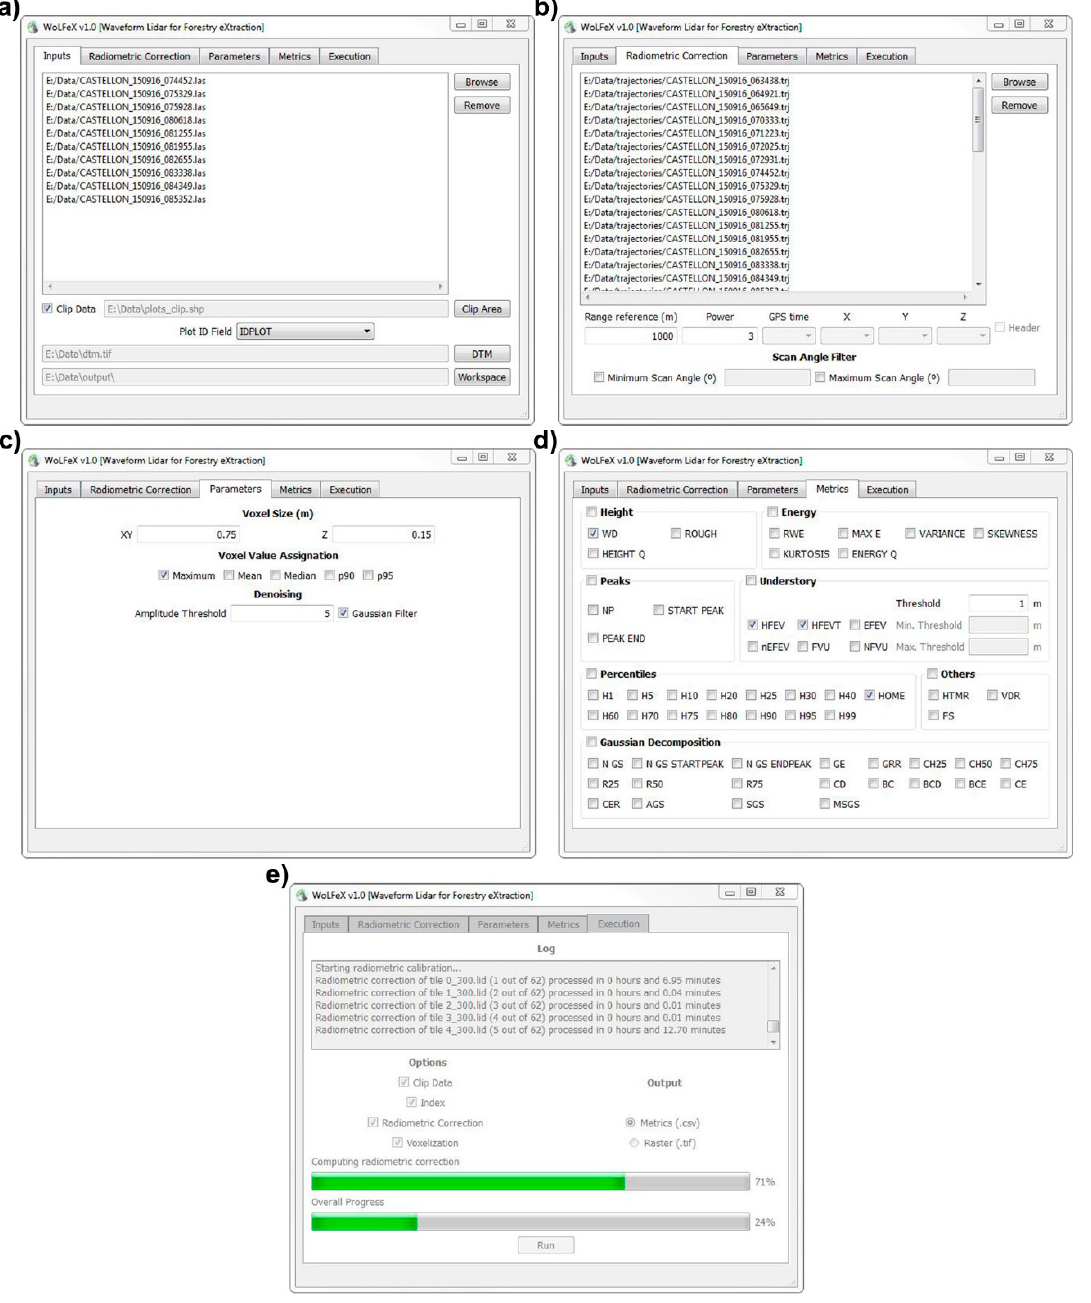
Figure 4. Graphic user interface of WoLFeX and the five different sections: ( a ) Inputs, ( b ) Radiometric correction, ( c ) Voxelization parameters, ( d ) Metrics, and ( e ) Execution.